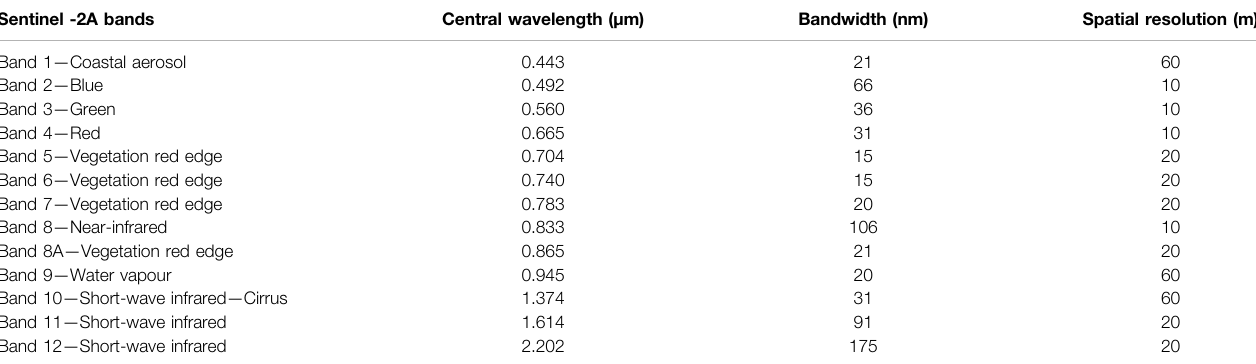
TABLE 1 | Characteristics of Sentinel-2A images.